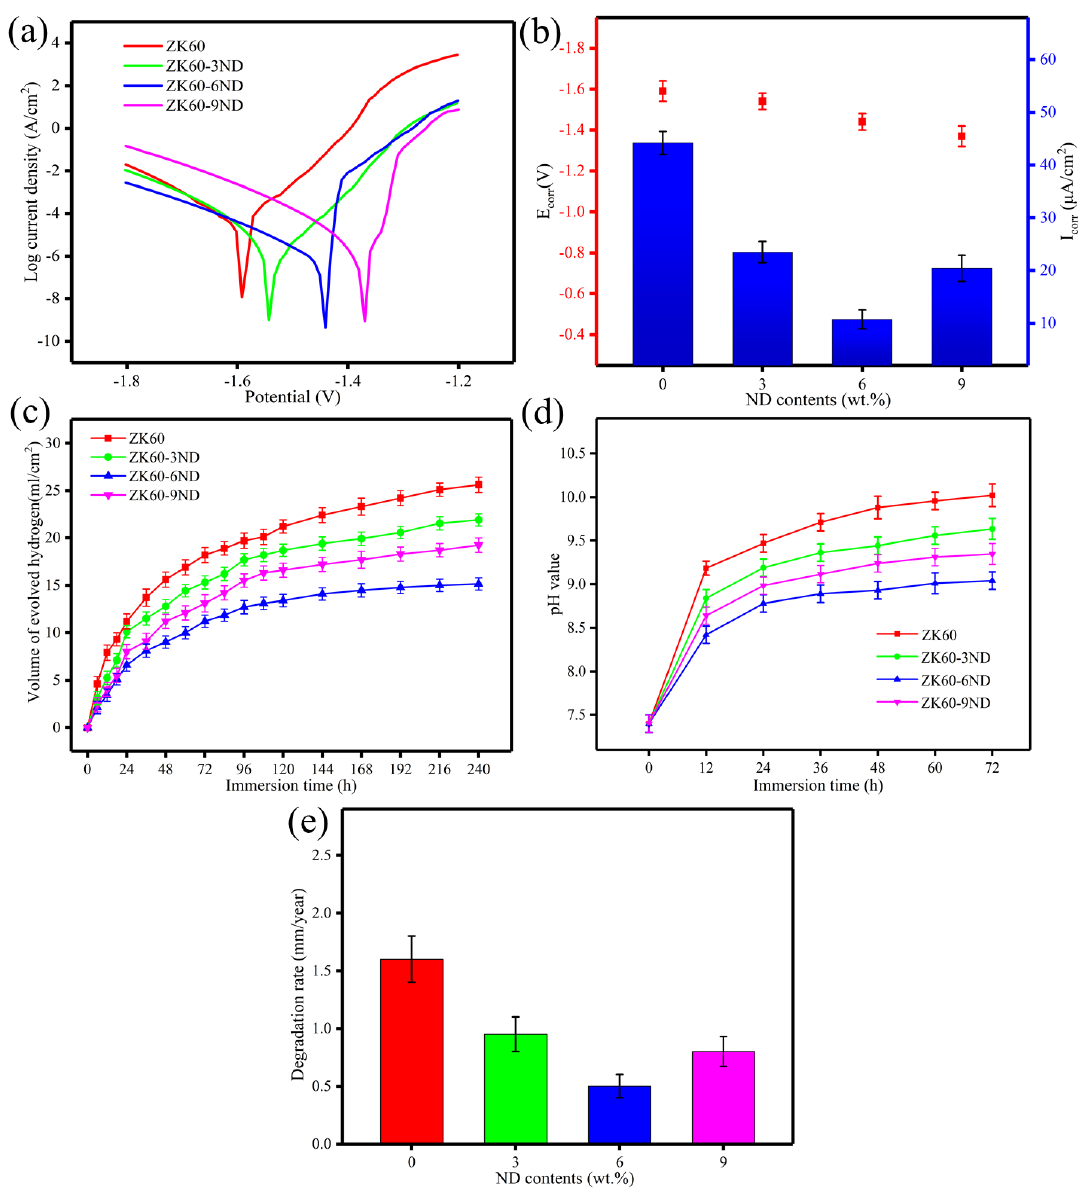
Figure 5. ( a ) Polarization curves of SLMd ZK60−xND and ( b ) corresponding corrosion potential ( E corr ) and corrosion current density ( I corr ) obtained from polarization curves; ( c ) the variations of hydrogen evolution volume of SLMed ZK60−xND immersed in SBF; ( d ) variation of pH value; ( e ) degradation rate based on weight loss test.